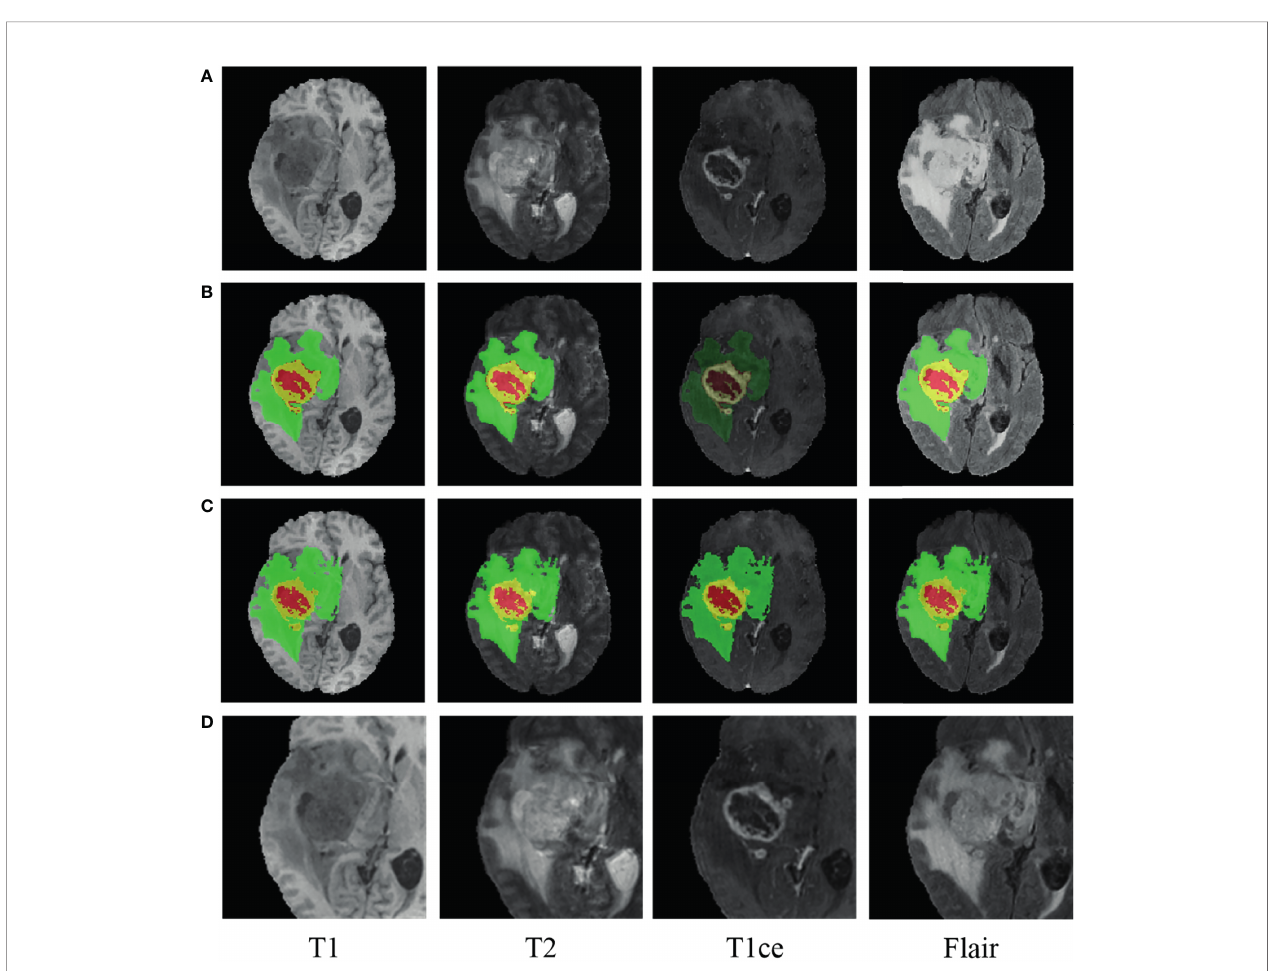
FIGURE 2 | An example of glioma patients on multimodal MRI images (patient ID: CPM19_CBICA_AAB_1, Glioblastoma). (A) Original images. (B) Tumor segmentation on panel (A) . (C) Ground truth on panel (A) . (D) Normalized followed centrally clipped from panel (A) based on panel (B)